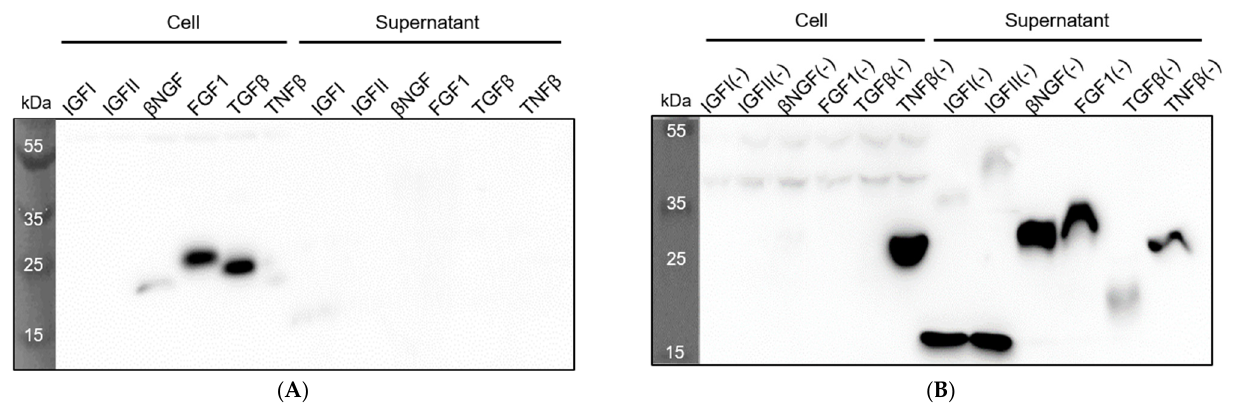
Figure 4. Wild type and recombinant growth factor secretion analysis of P. fluorescens Δ fleQ . Wild-type and recombinant proteins were detected using anti-LARD3 antibodies. P. fluorescens Δ fleQ cells were cultured in M9 medium for both ( A ) and ( B ). The growth factors were introduced into the cells using the pAD2 plasmid. ( A ) Western blotting of wild-type proteins expressed in cell lysate and secreted culture supernatant by P. fluorescens Δ fleQ . ( B ) Western blotting of recombinant proteins expressed in cell lysate and secreted culture supernatant by P. fluorescens Δ fleQ .